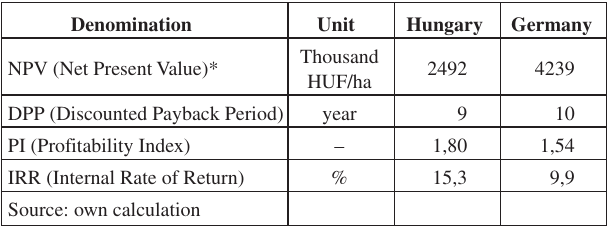
Table 5. Investment Efficiency Indicators of Apple Production in the Two Countries